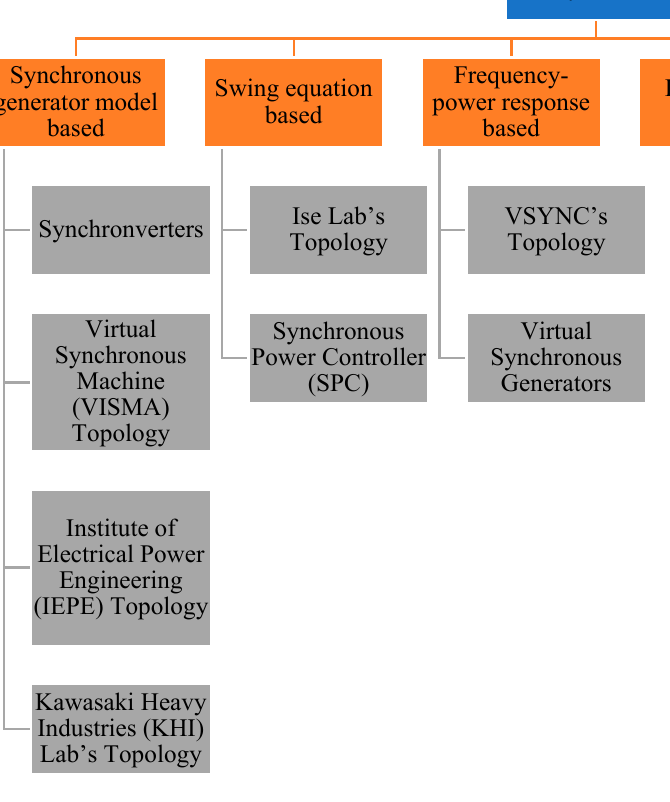
Figure 4. Topologies of VSM.